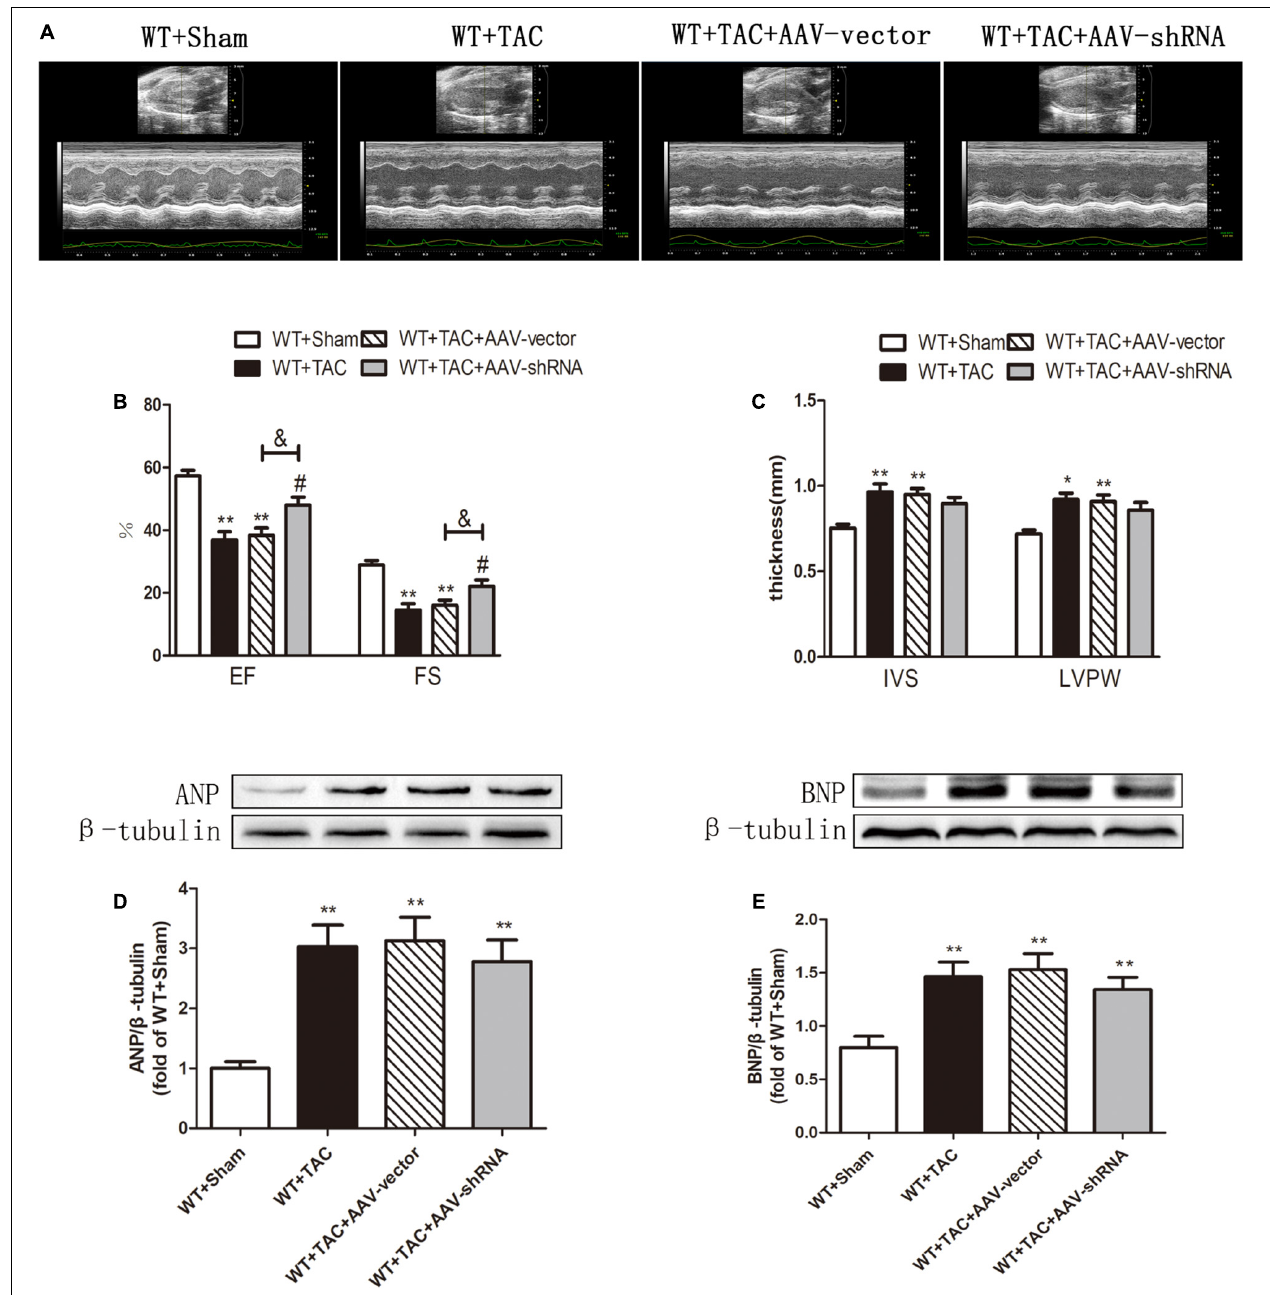
FIGURE 9 | Interference with RIPK3 can alleviate cardiac insufficiency in HF mice and has no significant improvement in the up-regulation of ANP and BNP. Male 8-week-old WT mice were pretreated with AAV-vector and AAV-shRNA through the tail vein, and TAC was performed using a 28-g needle. The control group received sham surgery. All groups of mice were given continuous feeding for 6 weeks. Hearts were then obtained for correlative testing. (A) Echocardiography. (B) EF and FS. (C) IVS and LVPW. (D) The expression of ANP at the protein level in myocardial tissue was detected by Western blotting analysis, and β -tubulin was used as a loading control. (E) The expression of BNP at the protein level in myocardial tissue was detected by Western blotting analysis, and β -tubulin was used as a loading control. Compared with WT + sham group, ** P < 0.01 and * P < 0.05; compared with WT + TAC group, # P < 0.05; compared with WT + AAV-vector group, & P < 0.05. n =